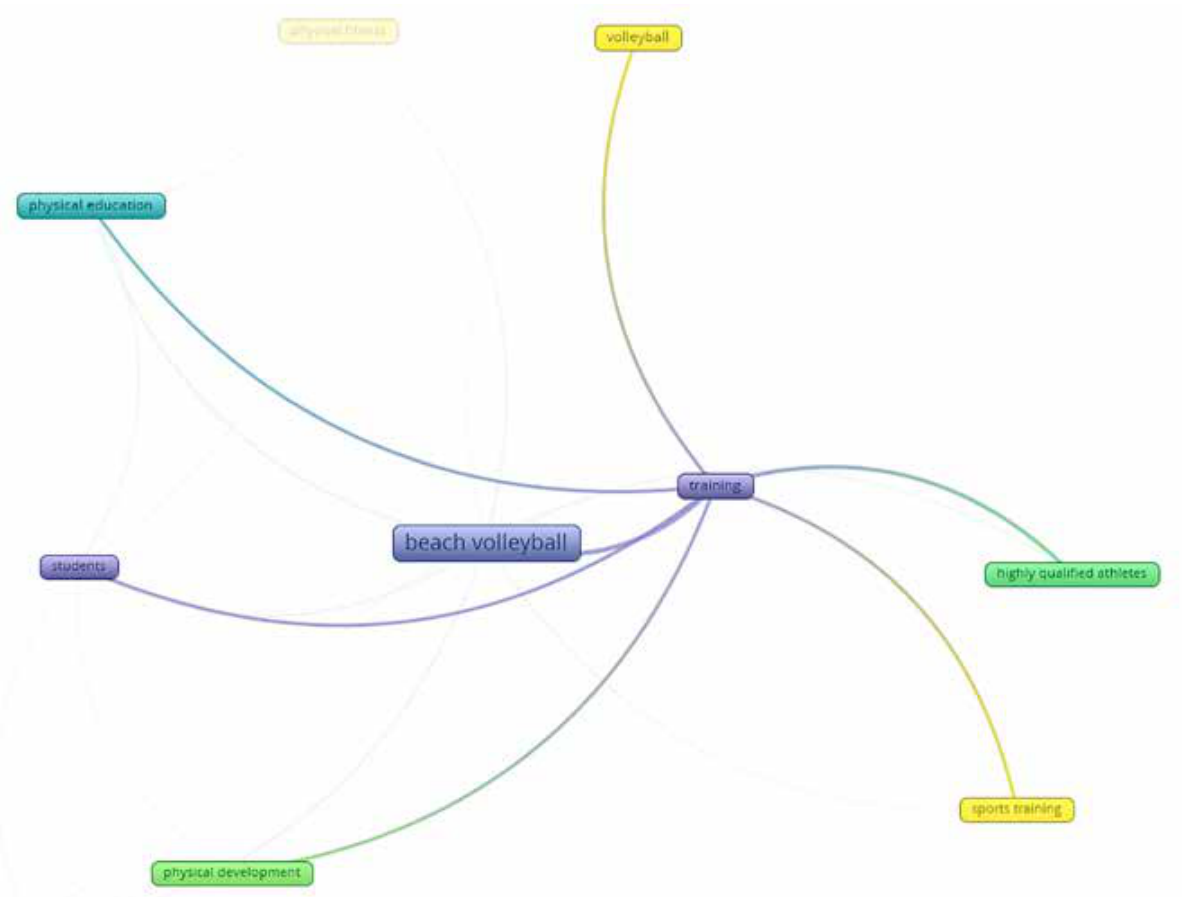
Figure 9. Relationship of the keyword “training” with other words (source: own research based on data extracted from SEL database and analyzed with VOSviewer;